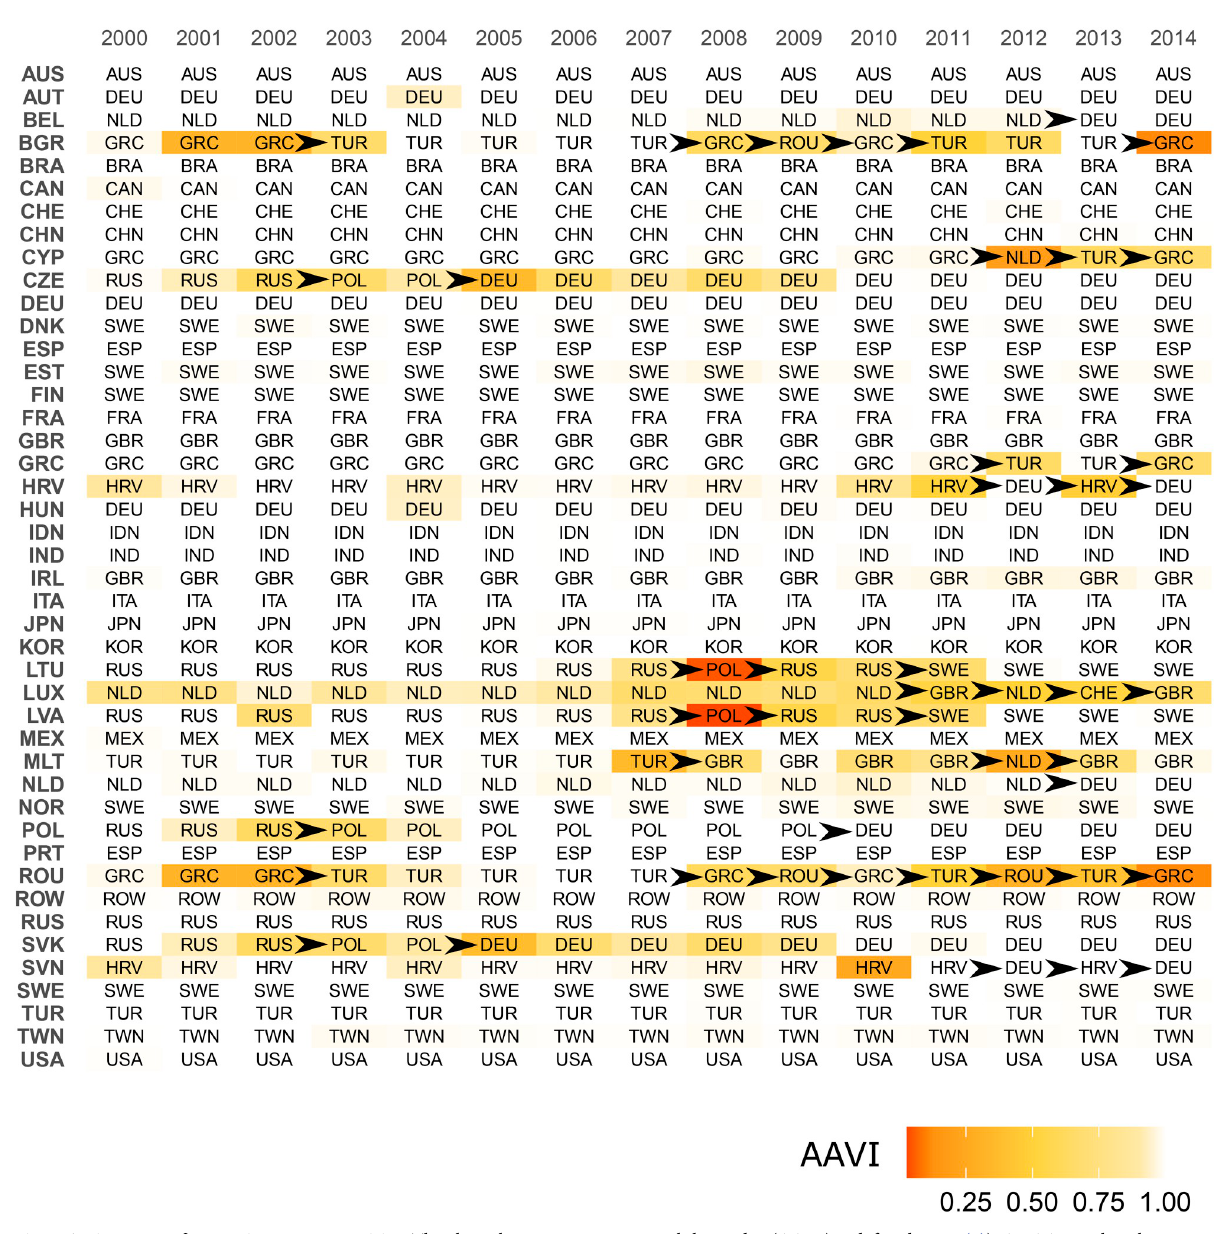
Fig 3. Assignment of countries to communities. The algorithmic assignment variability index (AAVI) is defined in Eq (3)). An AAVI value close to unity (light colors) indicates more reliable assignments. Black arrows highlight the cases in which the country changes its community.